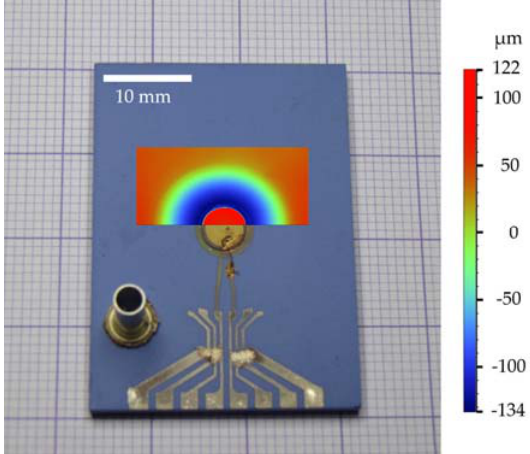
Figure 7. Depth map of the sensor’s diaphragm overlaid on a photograph of the sensor. The color scale bar revealing depth is shown on the right side of the photograph. Negative depth values refer to downward in ‐ plane curvature, while positive values to upward in ‐ plane curvature.